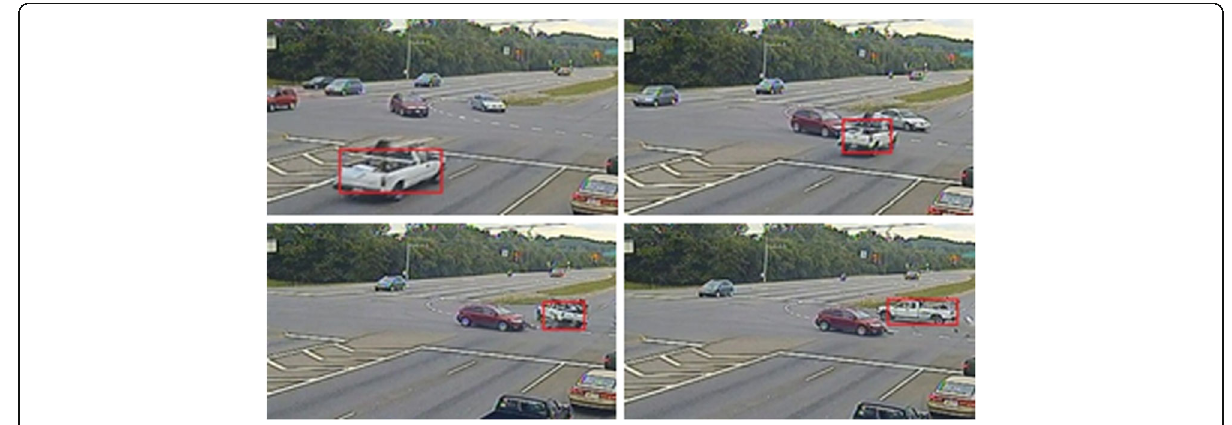
Fig. 19 Vehicle tracking results of proposed method based on extended mean-shift algorithm (images are from left to